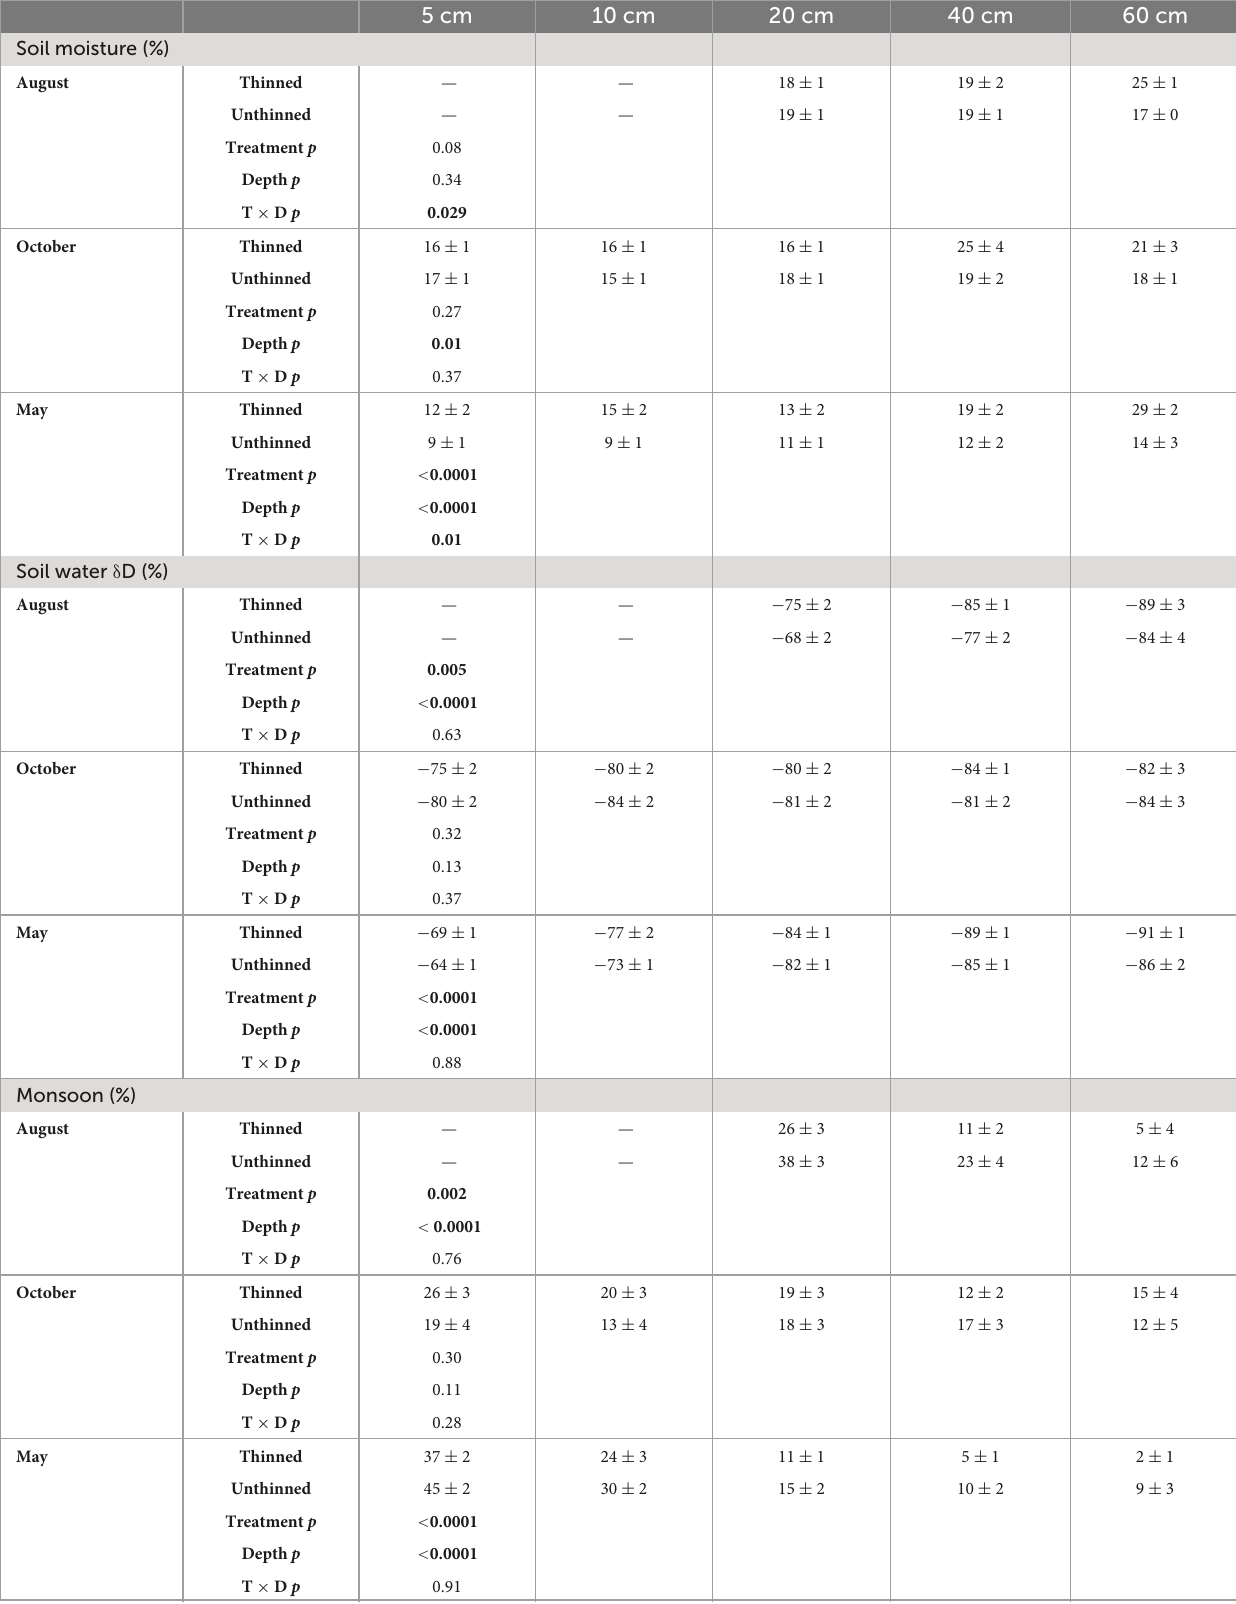
TABLE 1 Mean ( ± SE) soil moisture, isotopic composition, and monsoon proportions in August 2013, October 2013, and May